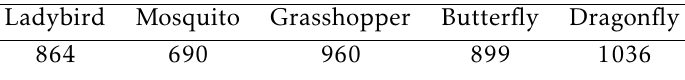
Table 1. Number of images per insect